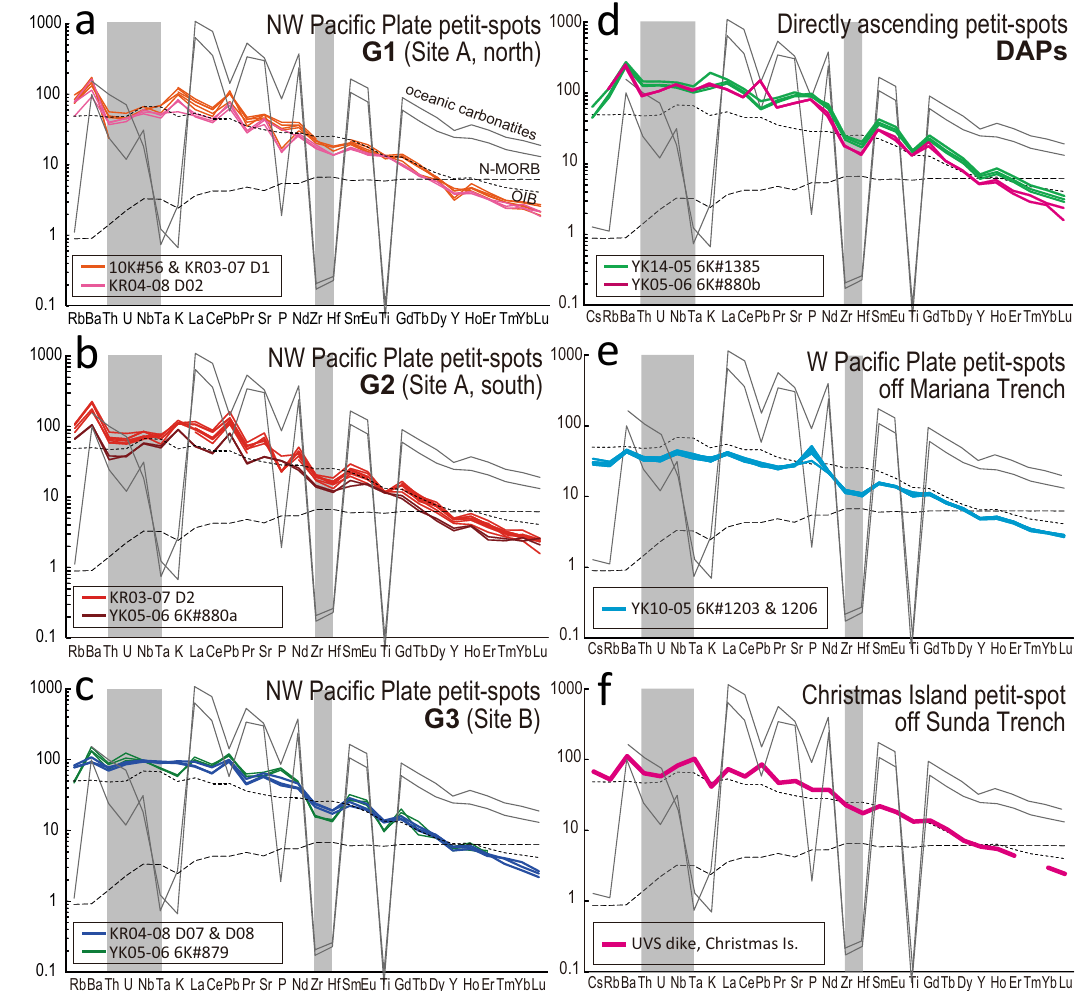
Fig. 5 Geochemistry in incompatible elements normalized by primitive mantle (spidergram) of various petit-spot lavas. a – d NW Paci fi c Plate petit- spots, e western Paci fi c Plate petit-spots, and f Christmas Island petit-spot off Sunda Trench. The lavas on “ oceanic carbonatite ” show thin gray patterns 76 . The representative N-MORB and OIB compositions are broken and dotted lines, respectibely 75 . Gray hatched bars correspond the compositions of Th, U, Nb, Ta, Zr, and Hf. Although the negative anomalies in Th, U, Nb, and Ta are mainly shown in G1 and G2 lavas of the NW Paci fi c Plate petit-spot, those in Zr and Hf are for all petit-spots as mentioned in Fig. 4. The data and the color legends are available in Supplementary Data